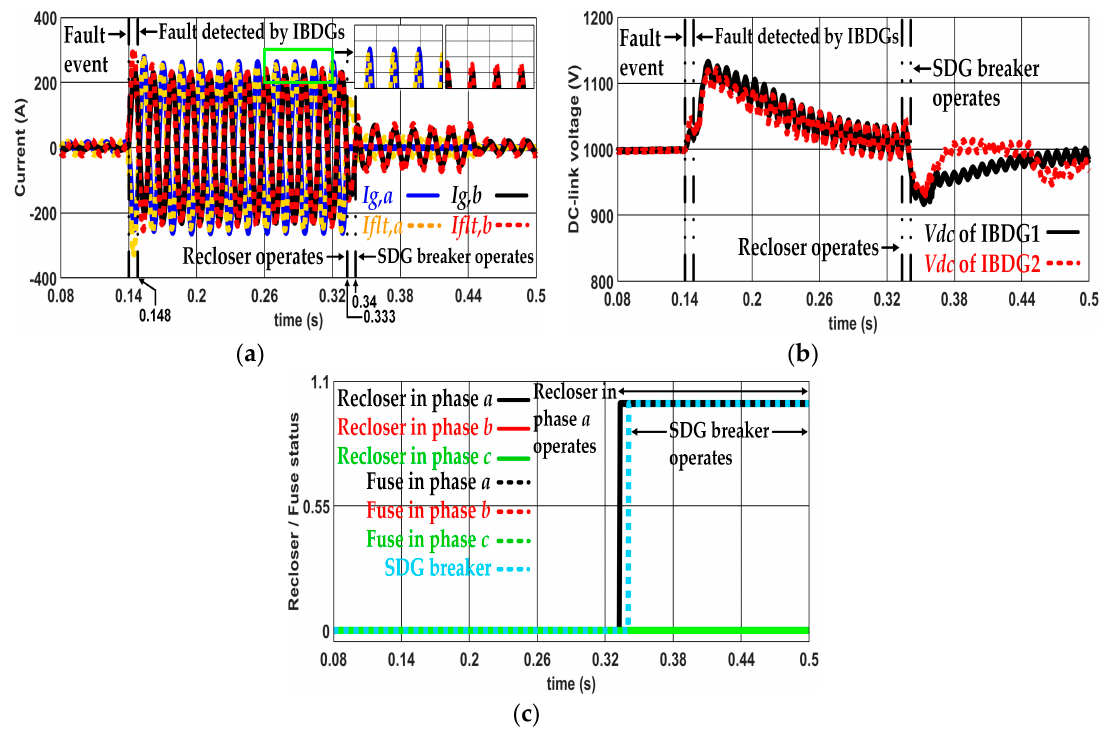
Figure 15. Separated phase–current control during temporary LL fault: ( a ) total fault current and grid current; ( b ) DC-link voltage; ( c ) operating time of recloser–fuse and SDG breaker.